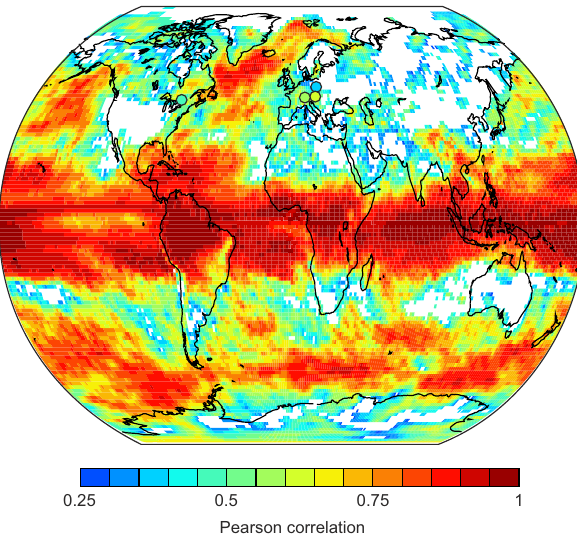
Fig. 9. Map of the Pearson correlation coefficient between annual mean temperature and PWT (calendar year) over the period 1979– 2012 calculated from ERA-Interim data. Circles denote correlations between annual mean temperature and annual δ 18 O at four GNIP stations (calculated as precipitation-weighted sum of monthly δ 18 O values). Only correlations that are significant ( p < 0.1), accounting for autocorrelation, are shown.